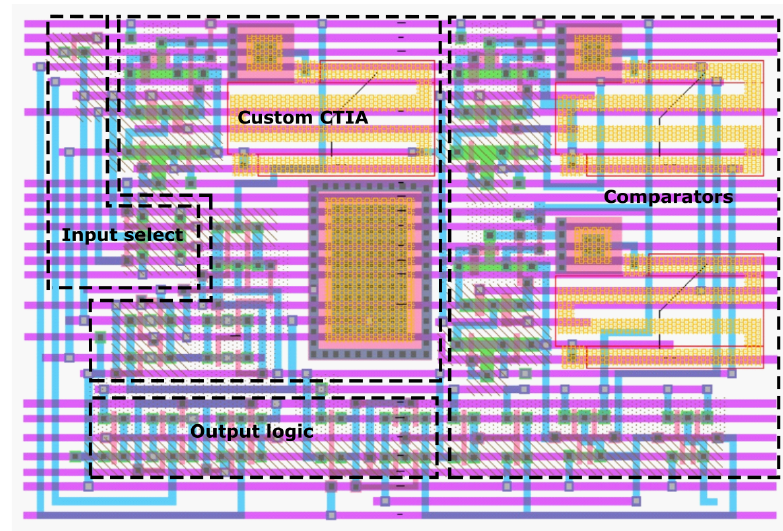
Figure 8. Layout of the defective pixel detection